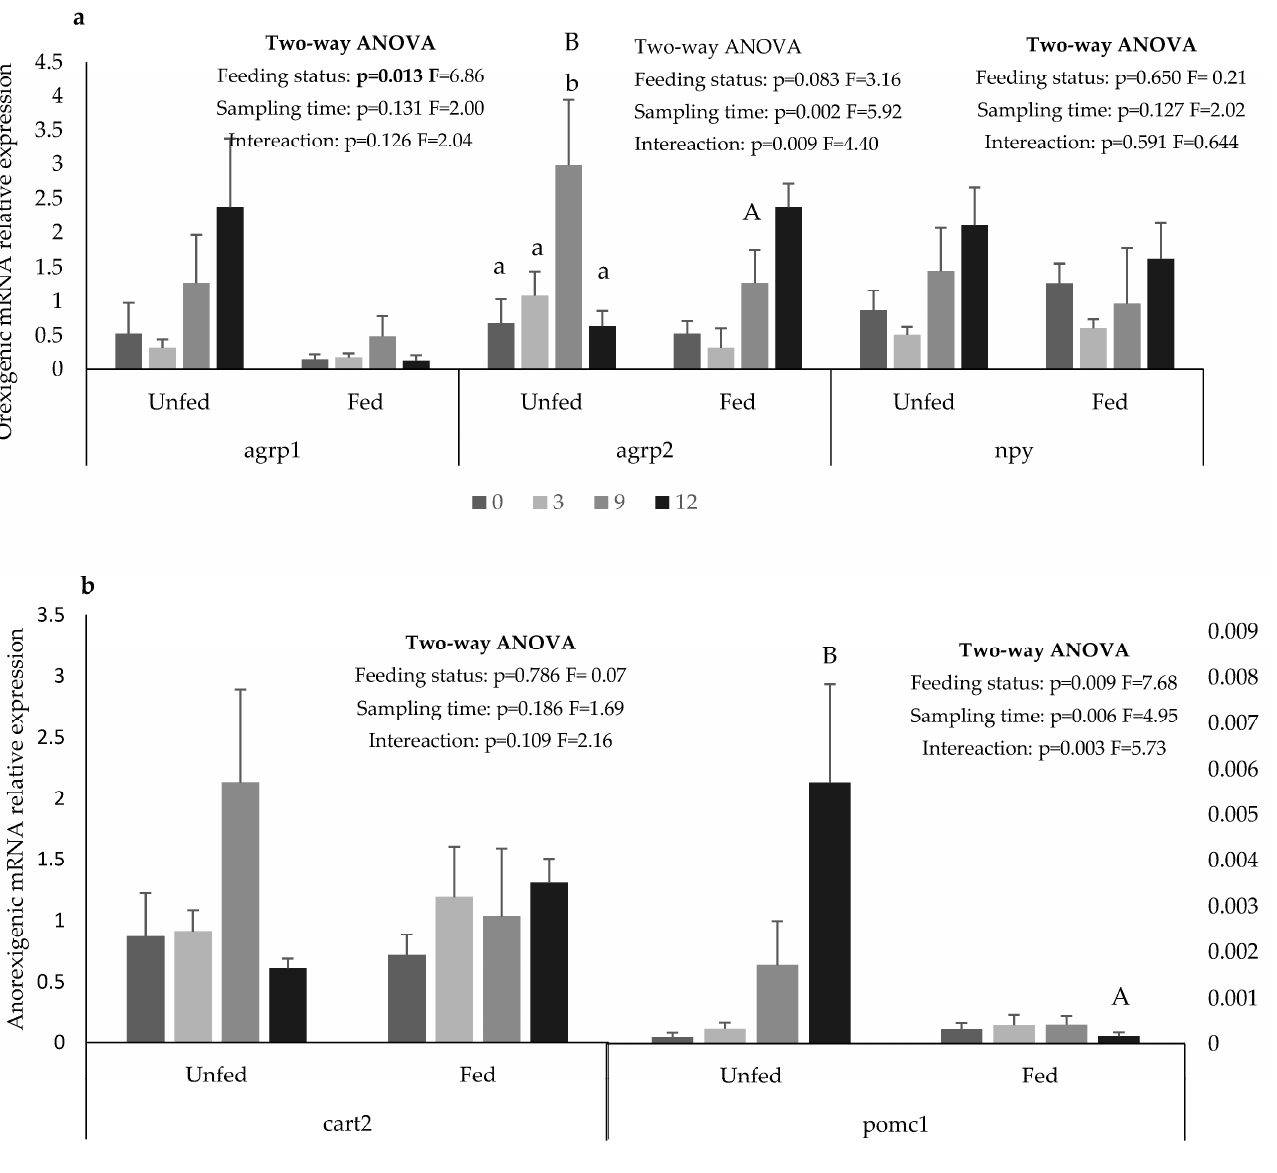
Figure 3. Orexigenic ( a ) and anorexigenic ( b ) expressions in the central system of European seabass juveniles after 8 days of feed deprivation (unfed) or continuous feeding (fed). Data were normalized with two housekeeping genes, ribosomal 18S (18S) and α‐ elongation factor (ef1), according to [56]. Values are presented as means and standard error (SE). Small letters denote significant differences in sampling time under the same feeding conditions and capital letters denote significant differences in sampling times regardless of the feeding conditions. py: neuropeptide Y; agrp: Agouti ‐ related protein; cart: cocaine ‐ and amphetamine ‐ regulated transcript; pomc: proopiomelanocortin.